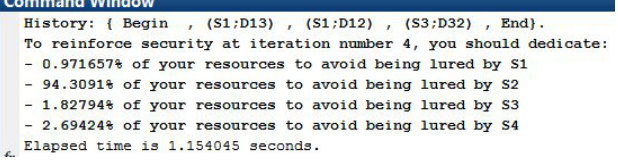
Figure 8. Case N o 2: